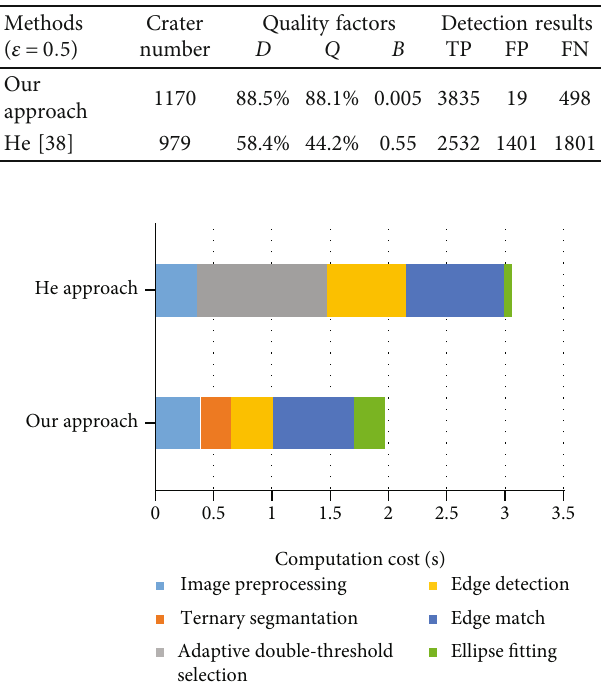
Table 8: Comparison with He ’ s CDA.